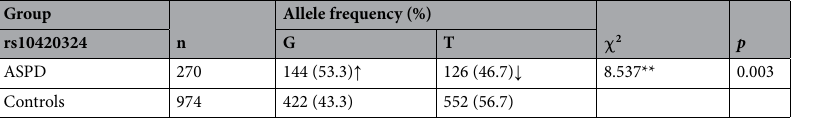
Table 2. Allele frequency difference between the ASPD and control groups. ASPD antisocial personality disorder. **Intergroup comparisons were tested by chi-square test.